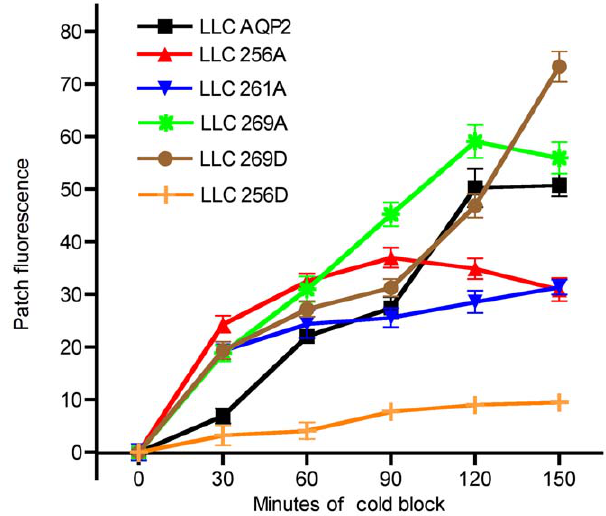
Figure 3. Quantified formation of AQP2 perinuclear patch after cold block at 20 6 C in cells expressing various AQP2 phosphor- ylation mutants. The time course of the development of the AQP2 perinuclear patch was quantified by measuring mean pixel intensity of the patch using IPlab software. The results are presented as the increase in mean patch fluorescence value starting from 0 minutes of cold block. The overall accumulation of the perinuclear patch reached a maximal density after cold block for 150 minutes with all mutants. The experiment was repeated in triplicate, N for each mean is $ 24. Bars represent standard